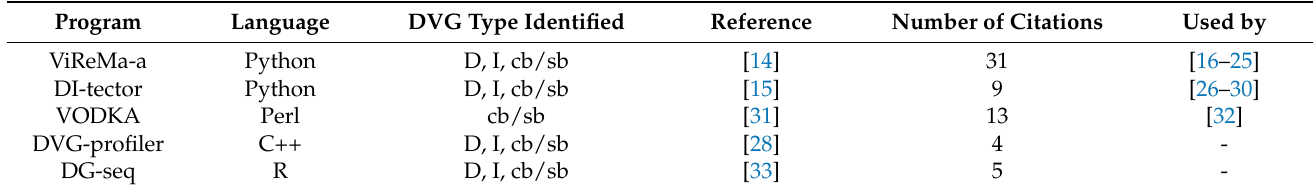
Table 1. Published tools for the identification of DVGs. Abbreviatures: D, deletion; I, insertion; cb/sb, copy- and/or snap-back. The last column enumerates the studies that have used each program (search on PubMed database, last accessed on 23 February